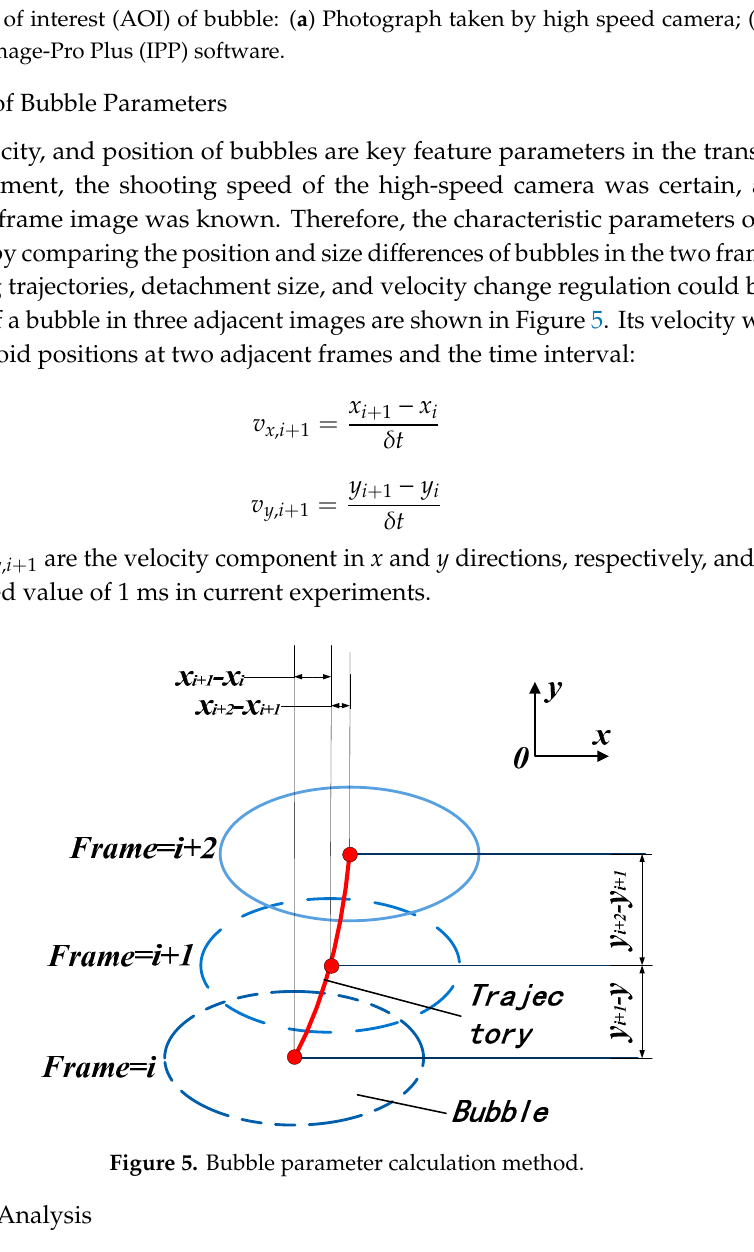
Figure 4. Area of interest (AOI) of bubble: ( a ) Photograph taken by high speed camera; ( b ) Image processed by Image-Pro Plus (IPP) software.